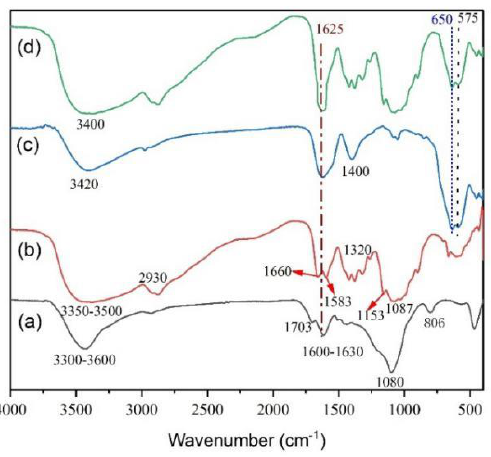
Figure 1. FT-IR spectra of CF ( a ), chitosan ( b ), Fe 3 O 4 ( c ) and CFS ( d ) materials. From Figure 1b, the absorption band at 3350–3500 cm − 1 was corresponded to the stretching vibrations of –OH, –NH 2 and –NH– groups of CS material. The peaks at 1660, 1583, and 1320 cm − 1 were attributed to the C=O, –NH– and –C–N– characteristic vibrations in the amide groups, respectively. The bands at 1153 and 1087 cm − 1 were corresponded to the –C–O– ether groups. The band at 2930 cm − 1 was assigned to the stretching vibration of –CH 2 of CS material. These results indicated that –COOH and –OH groups of CF can react with –OH and –NH 2 groups of chitosan completely. As shown in Figure 1c, the absorption peaks at 575 and 650 cm − 1 were assigned to the stretching vibration of the Fe–O bond of Fe 3 O 4 . The broad peaks near 3420, 1625 and 1400 cm − 1 were assigned to O–H stretching vibration and H–O–H bending vibration of adsorbed water on the Fe 3 O 4 surface. As can be seen from Figure 1d, the broad peaks at 3400 and 1625 cm − 1 were attributed to O–H stretching and H–O–H bending. The peaks at 575 and 650 cm − 1 were attributed to Fe–O stretching vibrations. These results indicated that the CFS was successfully